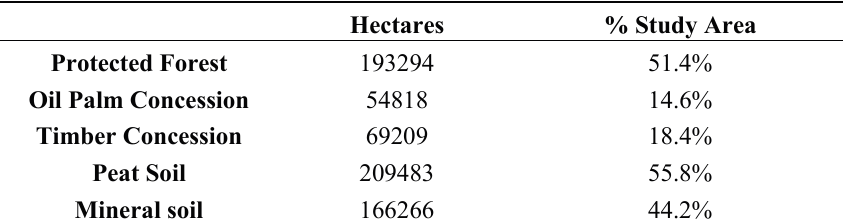
Figure 1. Study area location with detailed inset. Yellow polygon indicates extent of study area. (Image sources Google Earth, Image Date 4 October 2013) Table 1. 2010 Protected and Concession Areas and Soil Type Areas and as Percentage of Study